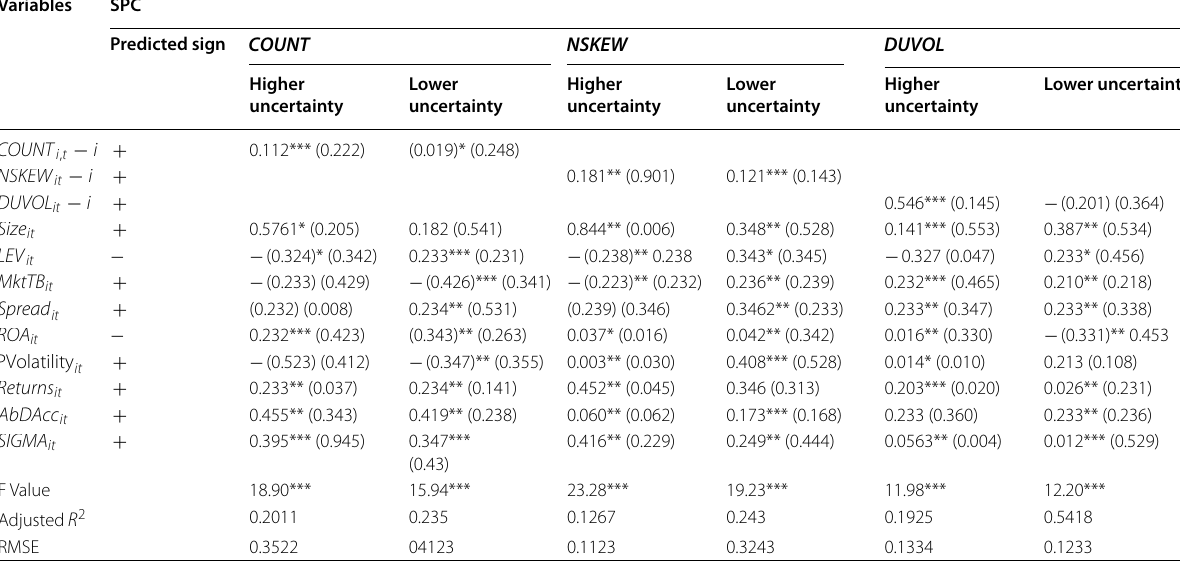
***significance for 0.01, **significance for 0.05, *significance for 0.1. parentheses show standard